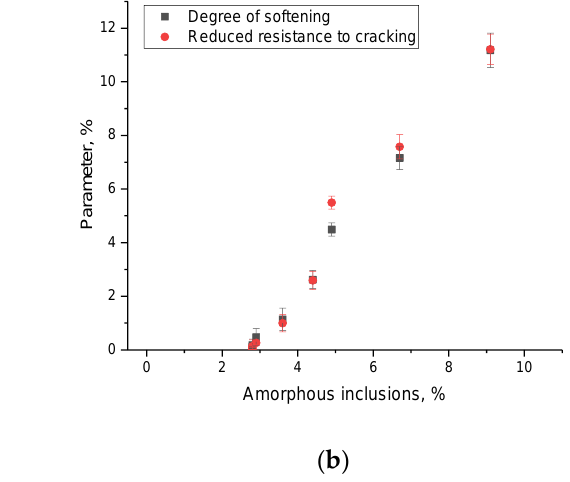
Figure 9. Data on changes in the degree of softening and crack resistance, depending on the crystal lattice swelling value ( a ) and the content of amorphous inclusions in the damaged layer ( b ).